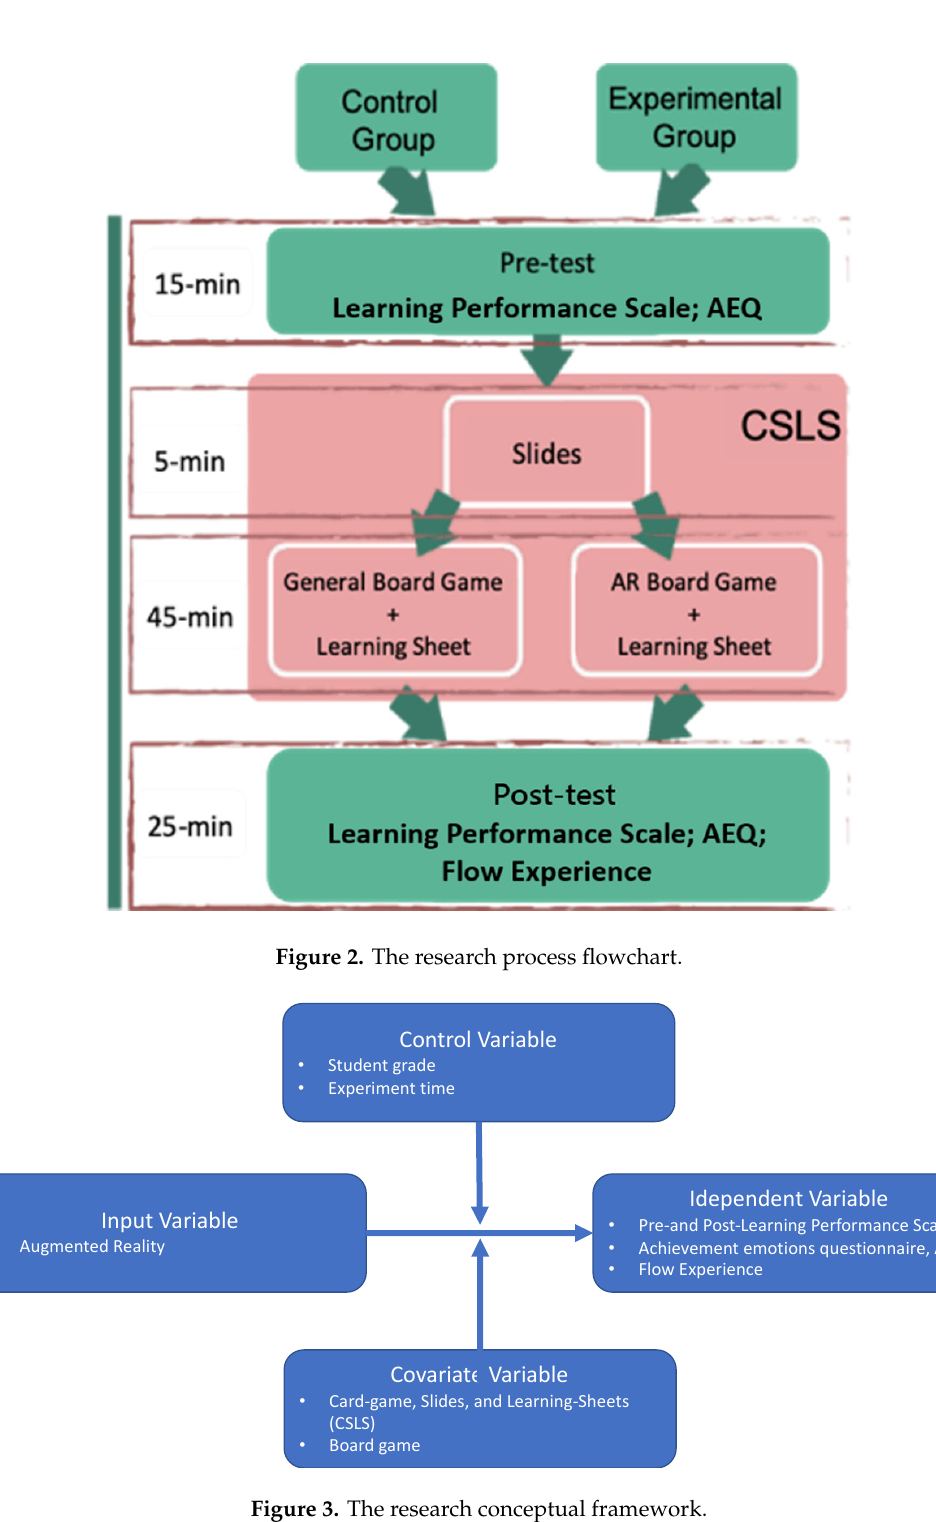
Figure 3. The research conceptual framework.